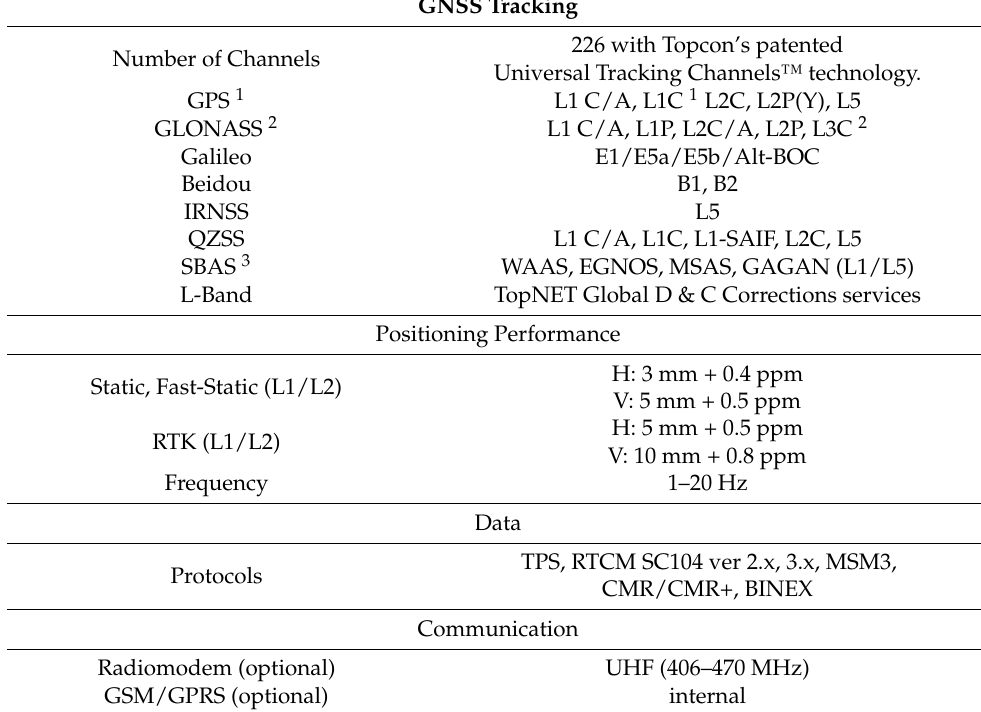
Table 3. Basic parameters of Topcon HiPer VR